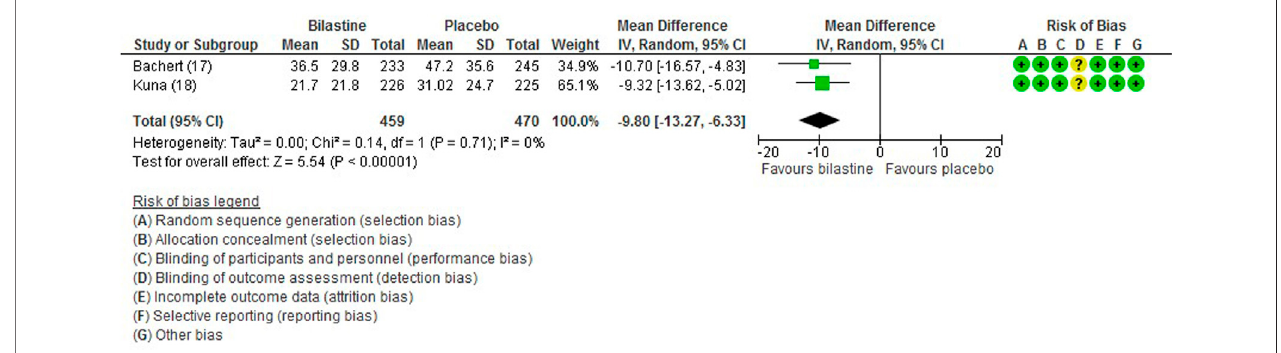
FIGURE 6 | Comparison between bilastine and placebo for non-nasal symptom score. SD Standard deviation, IV inverse variance, CI Con fi dence interval, df degrees of freedom.